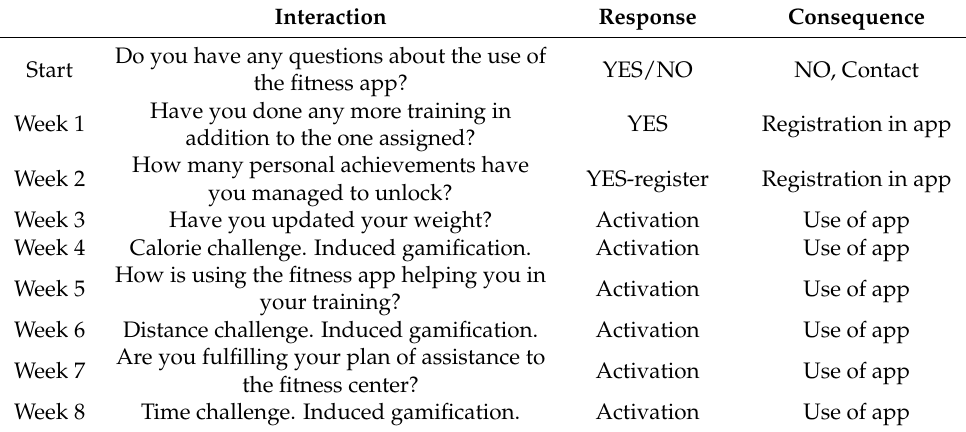
Table 2. Interactions with the experimental group in the intervention